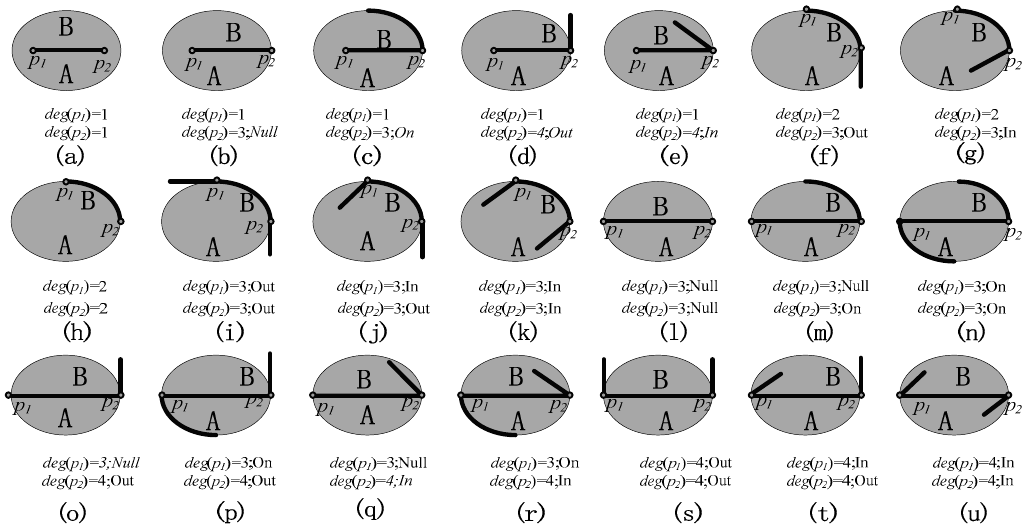
Figure 9. Twenty-one types of possible and asymmetric intersection-lines between lines and regions. ( a ) Case of degree-pair (1,1); ( b ) Case of degree-pair (1,3) and the adjacent point kind of p 2 is Null; ( c ) Case of degree-pair (1,3) and the adjacent point kind of p 2 is On; ( d ) Case of degree-pair (1,4) and the adjacent point kind of p 2 is Out; ( e ) Case of degree-pair (1,4) and the adjacent point kind of p 2 is In; ( f ) Case of degree-pair (2,3) and the adjacent point kind of p 2 is Out; ( g ) Case of degree-pair (2,3) and the adjacent point kind of p 2 is In; ( h ) Case of degree-pair (2,2); ( i ) Case of degree-pair (3,3) and the adjacent point kinds of p 1 and p 2 are both Out; ( j ) Case of degree-pair (3,3) and the adjacent point kinds of p 1 is In and p 2 is Out; ( k ) Case of degree-pair (3,3), and the adjacent point kinds of p 1 and p 2 are both In; ( l ) Case of degree-pair (3,3), and the adjacent point kinds of p 1 and p 2 are both Null; ( m ) Case of degree-pair (3,3), and the adjacent point kinds of p 1 is Null and p 2 is On; ( n ) Case of degree-pair (3,3), and the adjacent point kinds of p 1 and p 2 are both On; ( o ) Case of degree-pair (3,4), and the adjacent point kinds of p 1 is Null and p 2 is Out; ( p ) Case of degree-pair (3,4), and the adjacent point kinds of p 1 is On and p 2 is Out; ( q ) Case of degree-pair (3,4), and the adjacent point kinds of p 1 is Null and p 2 is In; ( r ) Case of degree-pair (3,4), and the adjacent point kinds of p 1 is On and p 2 is In; ( s ) Case of degree-pair (4,4), and the adjacent point kinds of p 1 and p 2 are both Out; ( t ) Case of degree-pair (4,4), and the adjacent point kinds of p 1 is In and p 2 is Out; ( u ) Case of degree-pair (4,4), and the adjacent point kinds of p 1 and p 2 are both In.